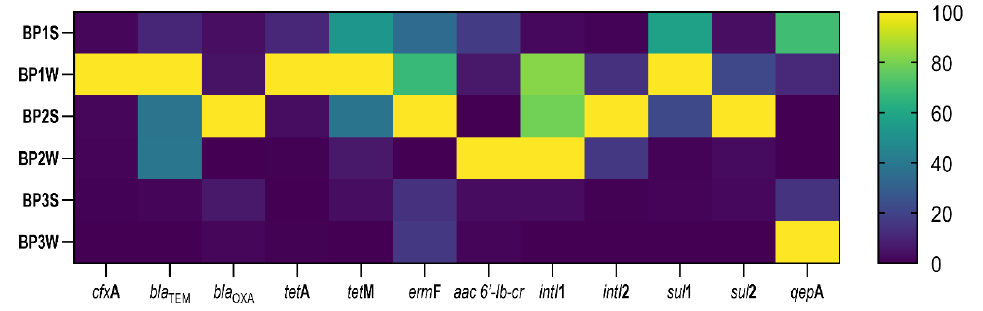
Figure 2. Normalized heatmap (%) presenting the absolute abundance (AA) of antibiotic resistance and integrase genes in digestate samples (number of copies/g of